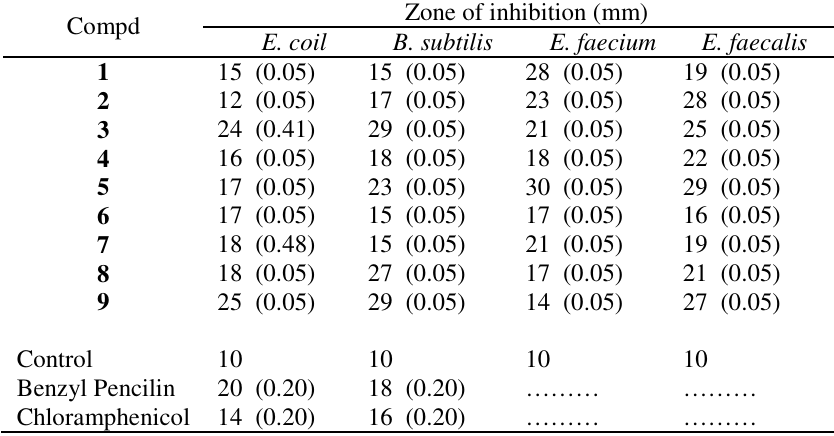
Table 3. Antibacterial activity of compounds ( 1-9